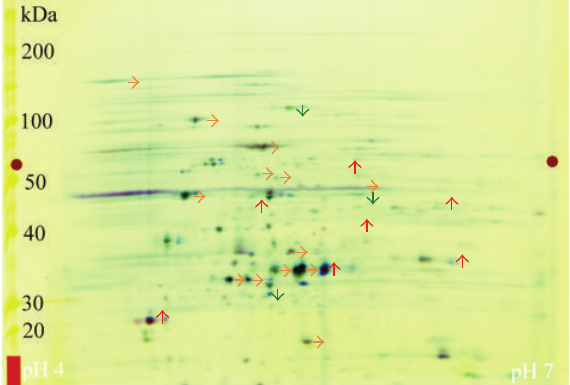
Figure 1: A representative 2D-DIGE gel of RW1 showing the contrast in protein expression between cells grown on acetate and dibenzofuran. Proteins that are expressed equally for the two conditions are marked with an orange arrow; di ff erentially expressed proteins are shown with green (higher on acetate) or red (higher on dibenzofuran)